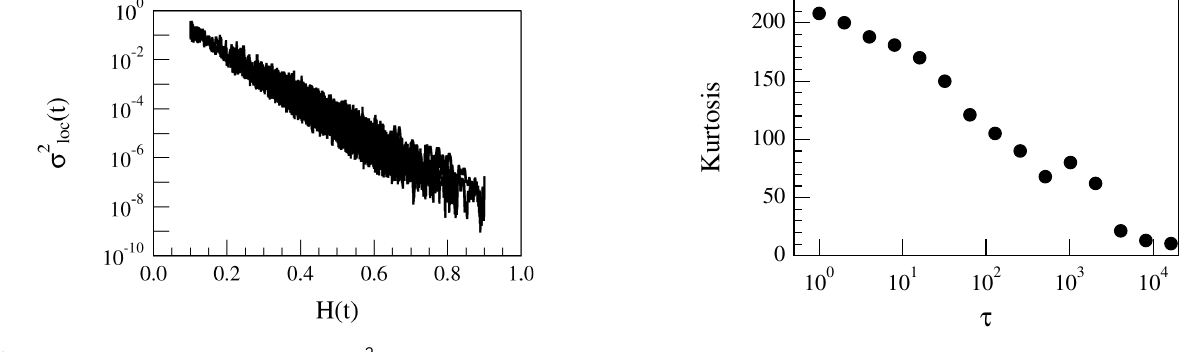
Fig. 3. Plot of the local variance σ 2 Hurst/H¨older exponent H(t) .